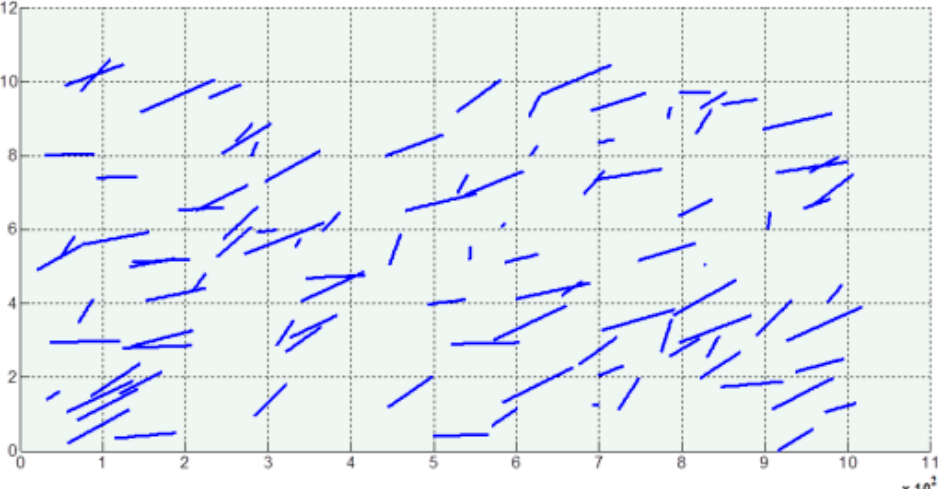
Figure 10. The simulating orbital trajectory of space debris in 100 different motion